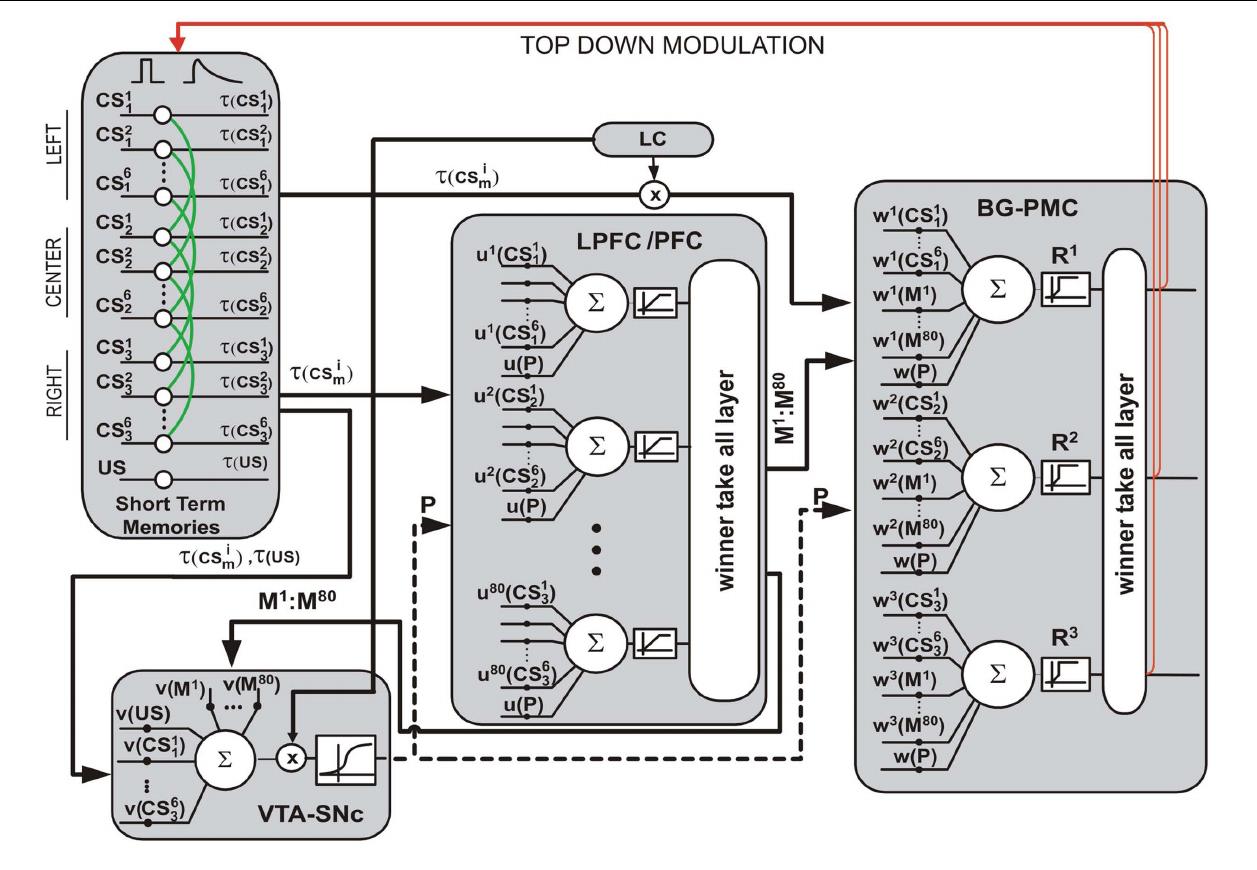
quantity of neurons in the LPFC structure is one of the subjects of this research and by default its value is 80. Here, the BG–PMC block is the output layer of the model.This layer executes the behavioral responses R 1 , R 2 , or R 3 . Neurons in this structure integrate information from visual inputs, the LPFC, and theVTA–SNc. As in the LPFC structure, a winner-take-all mechanism is applied to the output of the neurons in order to avoid the execution of multiple responses.Top-down modulation is shown in red whereas Hebbian-like synapses at visual stages are shown in green. A glossary containing parameters values and their definitions is appended at the end of this